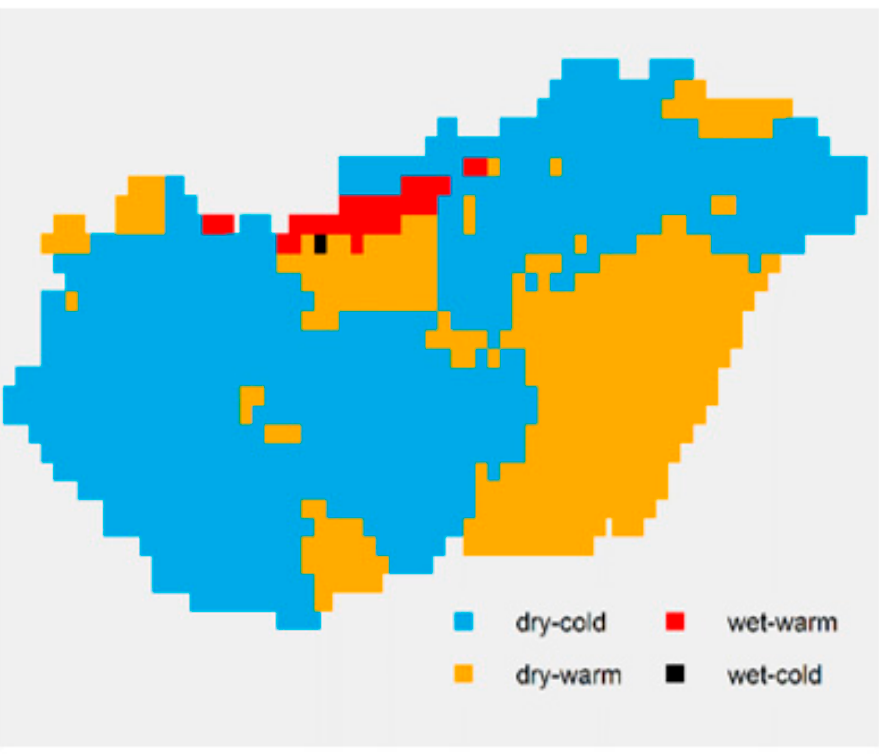
Figure A20. Characteristics of extreme months (November).